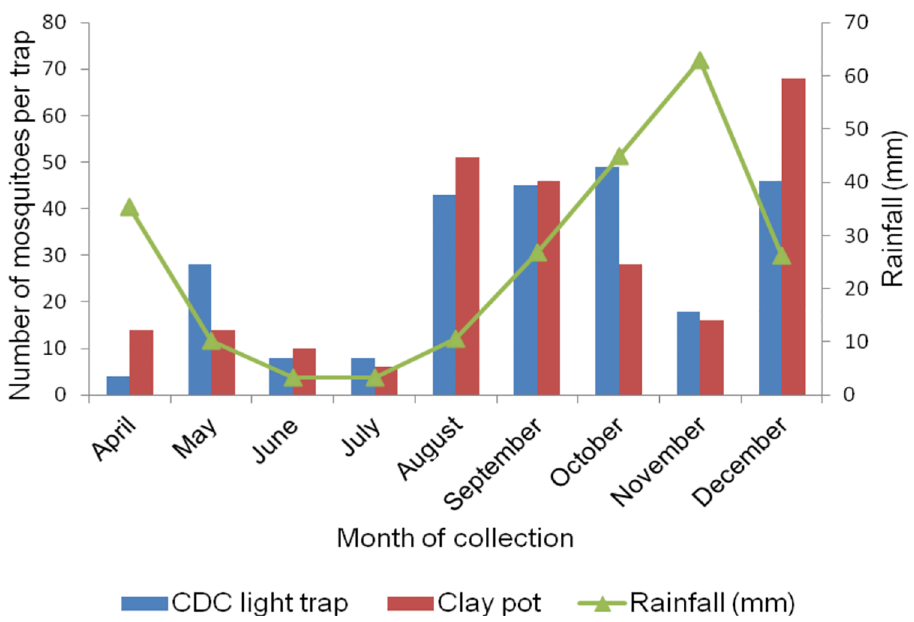
Fig 7. Monthly collection of anopheline mosquitoes in Katunguru village, Sengeremadistrict monitored using CDC light traps and clay pot methods. The rainfalldata was obtainedfrom climate data library